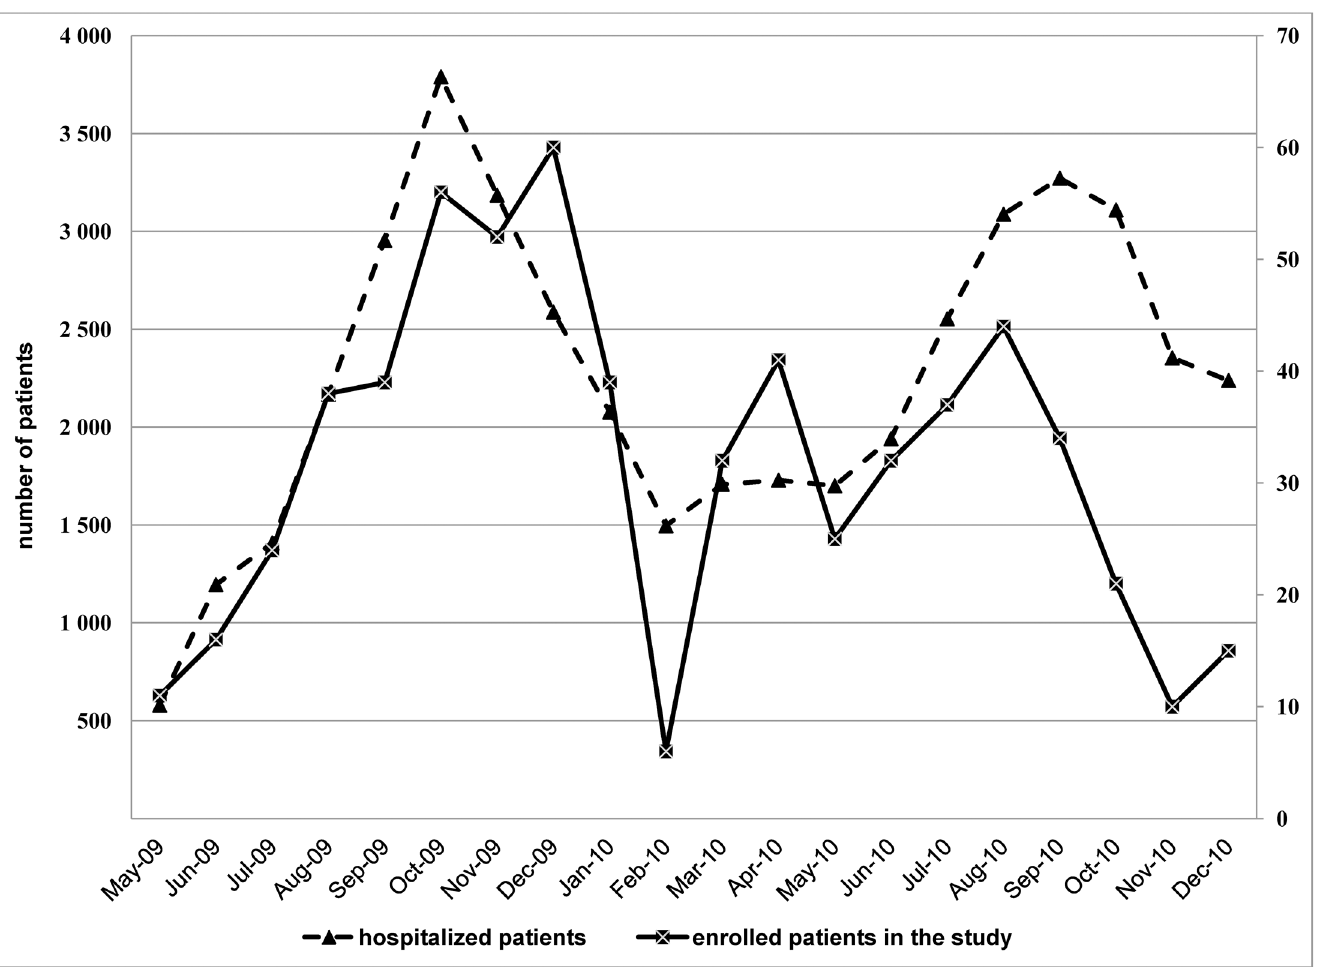
Fig 1. Number of cases enrolled and total numbers of LRTI children hospitalized in two referral pediatric hospitals in southern Vietnam, May 2009 to December 2010. A total of 106/632 (17%)of cases met at least one clinical criterion for severe disease, and 43% (271/632) were hospitalized for > 7 days. Among the children requiring supplemental oxygen or ventilatory support, 16/93 (17%) received NCPAP, 2/93 (2%) were intubated.